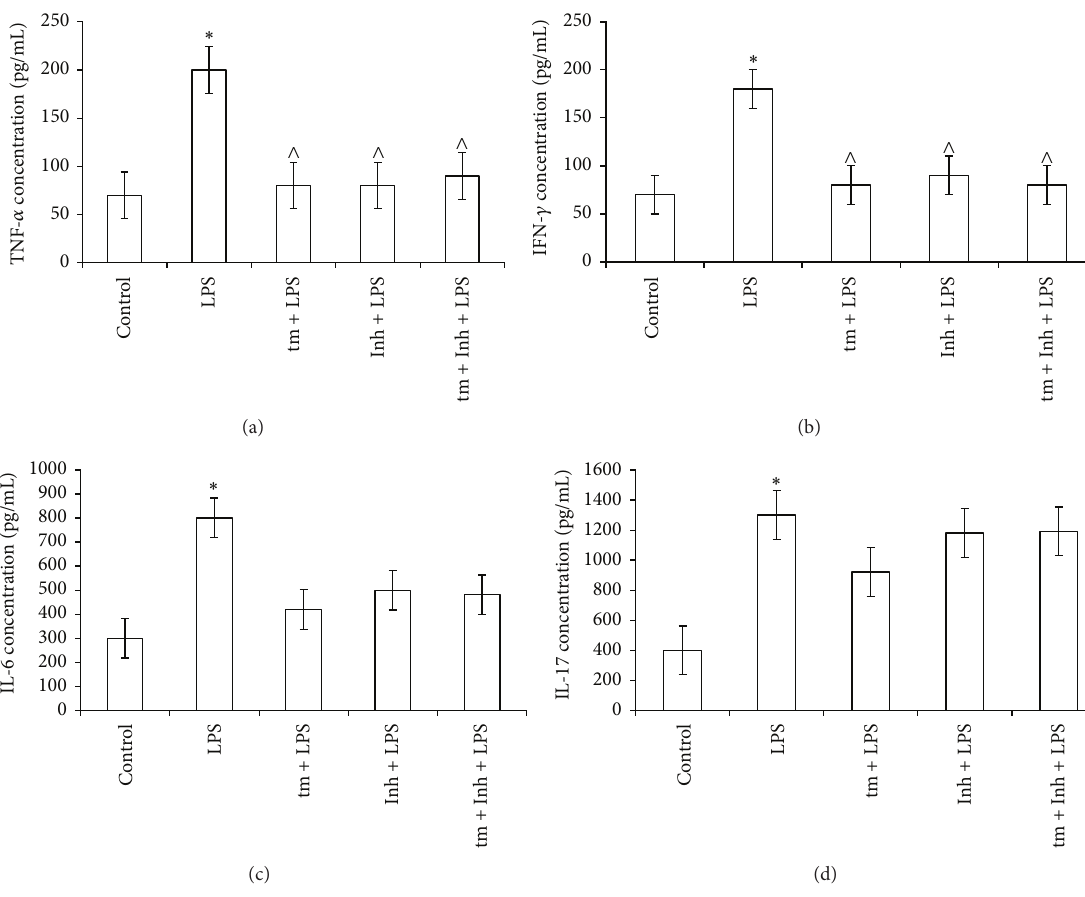
Figure 3: Plasma cytokine values in inflammation-bearing mice treated with thymulin and IKK Inhibitor XII. Five mouse groups were used: IB mice; IB mice pretreated with 20 mg/kg inhibitor; IB mice pretreated with thymulin; IB mice pretreated with thymulin plus inhibitor; and untreated controls. Each group consisted of 4 animals, which were examined individually. Each value is average mean ± SD from four mice; the measurements were made for each individual mouse in six duplicates. Data are expressed in pg/mL of plasma. ∗ Significantly different from control, 𝑃 < 0.05 . ∧ Significantly different from LPS-group, 𝑃 < 0.05 .